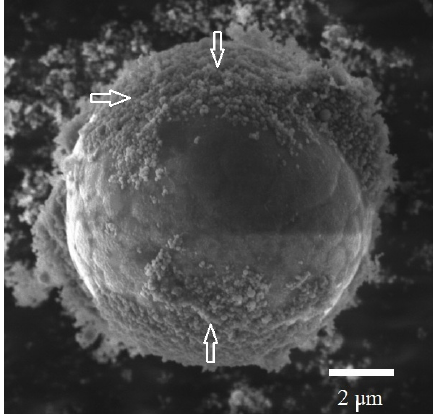
Figure 7. SEM image of nanoparticles and submicroparticles located on the surface of the micropar- ticle (shown by arrows) (Sample